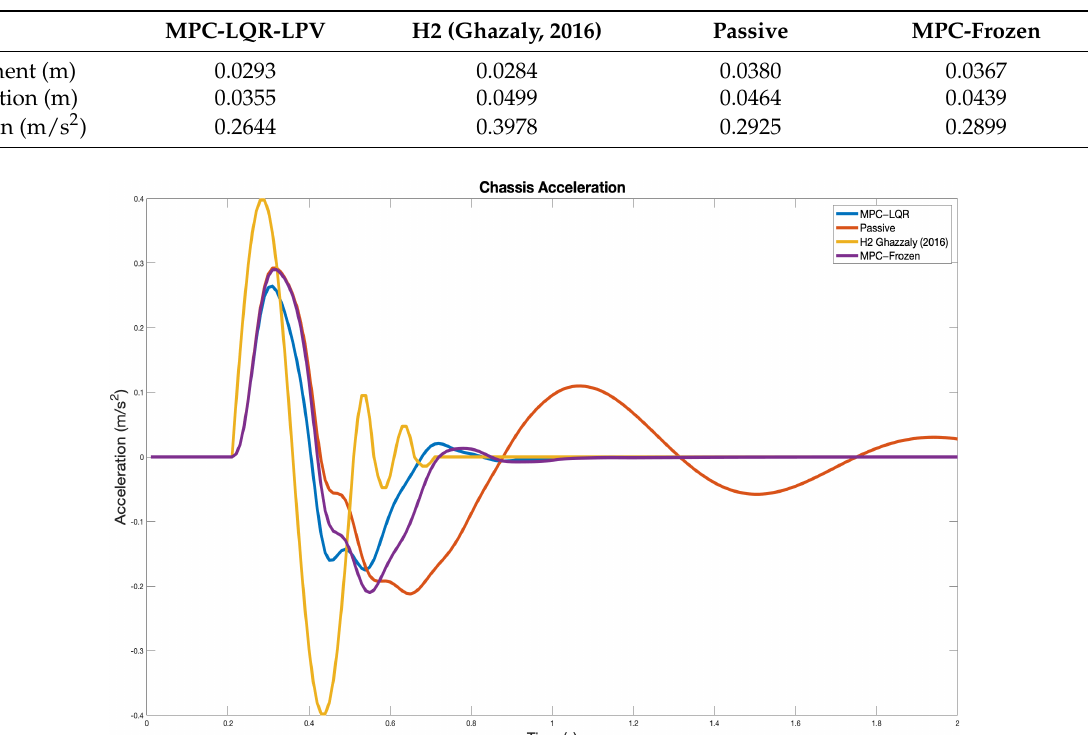
Table 3. Max Values performance.